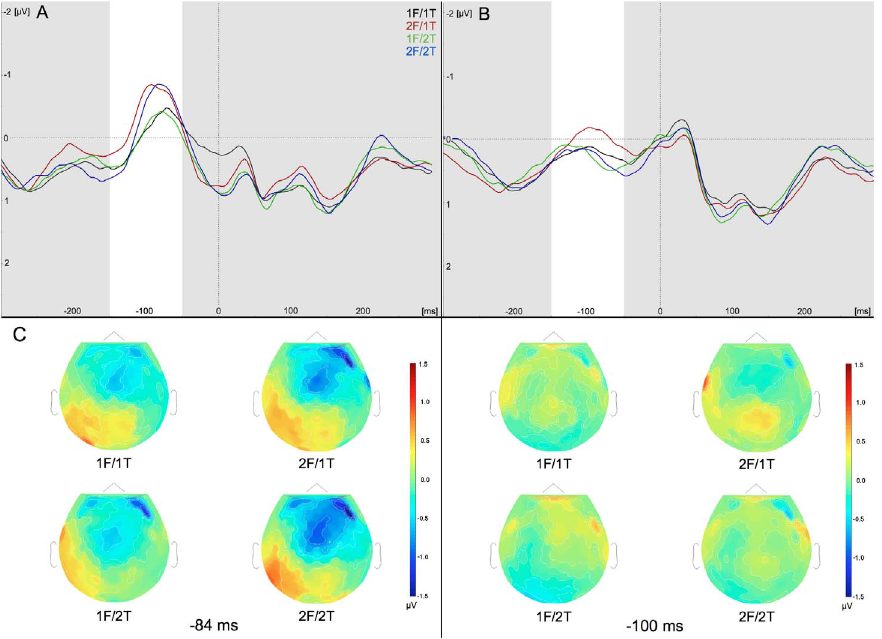
Figure 5. The amplitude of the anterior N2 was higher in the incongruent direction condition when two fingers were represented in the flanker. Response alternatives were defined by the number of fingers represented in the target and flanker: one-finger flanker (1F) and one- finger target (1T), or two-finger flanker (2F) and two-finger target (2T). ( A ) Grand-average waveforms from 2 300 to 300 ms locked to the response at the FCz ROI in the incongruent direction condition. ( B ) Grand-average waveforms from 2 300 to 300 ms locked to the response at the FCz ROI in the congruent condition. ( C ) Scalp topographies of the grand-average waveforms in the incongruent direction condition at 84 ms before the response. ( D ) Scalp topographies of the grand-average waveforms in the congruent condition at 100 ms before the response. Highlighted timeframe on grand- averaged waveforms represents the window used for detecting the peak amplitude of the anterior N2.